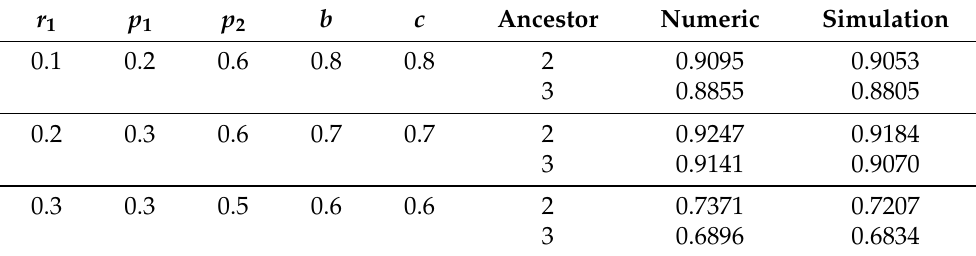
Table 2. Comparison of the numeric values of the extinction probabilities and their relative frequen- cies from 10 5